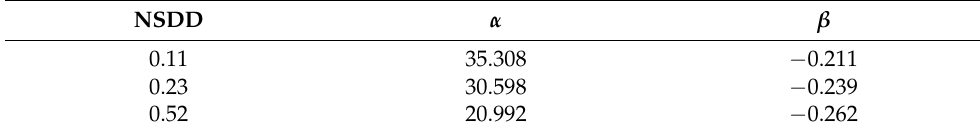
Table 3. Values of parameters α and β .